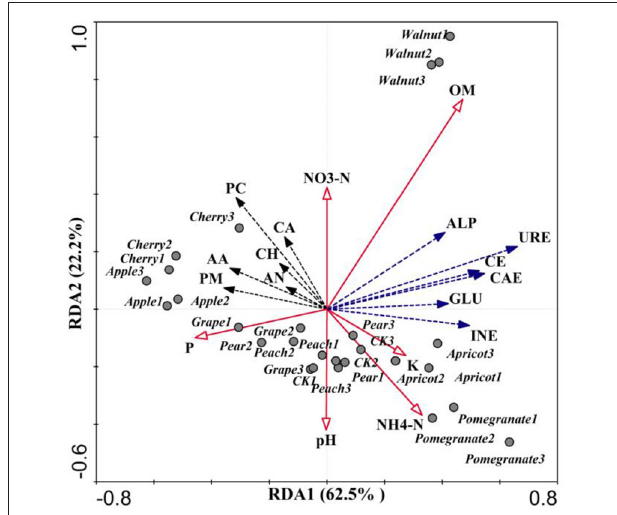
FIGURE 6 | Redundancy analysis (RDA) of microbial communities using bacterial and fungal genus relative abundances. Community-level physiological profile (URE, urease; CAE, catalase; GLU, β -glucosidase; CE, cellulase; INE, invertase; ALP, alkaline phosphatase) of six types of substrates (PM, polymers; CH, carbohydrate; PC, phenolic compounds; CA, carboxylic acids; AA, amino acids; AN, amines) and mineral element content (OM, organic matter; K, available potassium; P, available